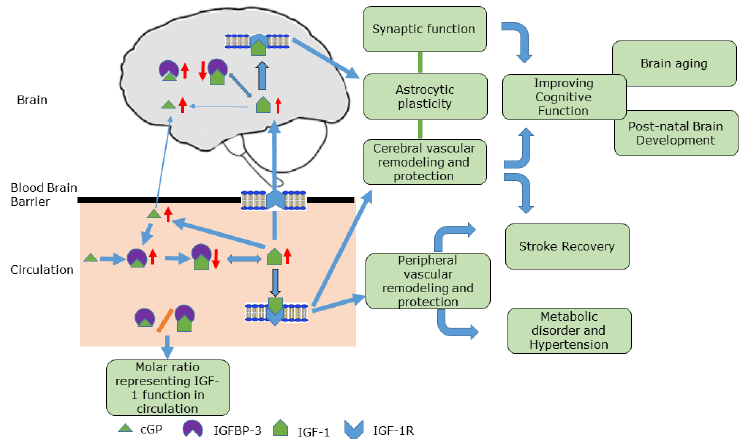
Figure 3. A graphic abstract showing the role of cGP in regulating the amount of bioavailable IGF-1 in circulation (pink area) and in brain tissues (grey area). These collectively improve IGF-1 operation in vascular function, and potentially provide beneficial effects on cerebral and systemic vascular diseases. The molar ratio of cGP/IGF-1 in plasma represents the amount of bioavailable IGF-1, and thus the function of IGF-1.